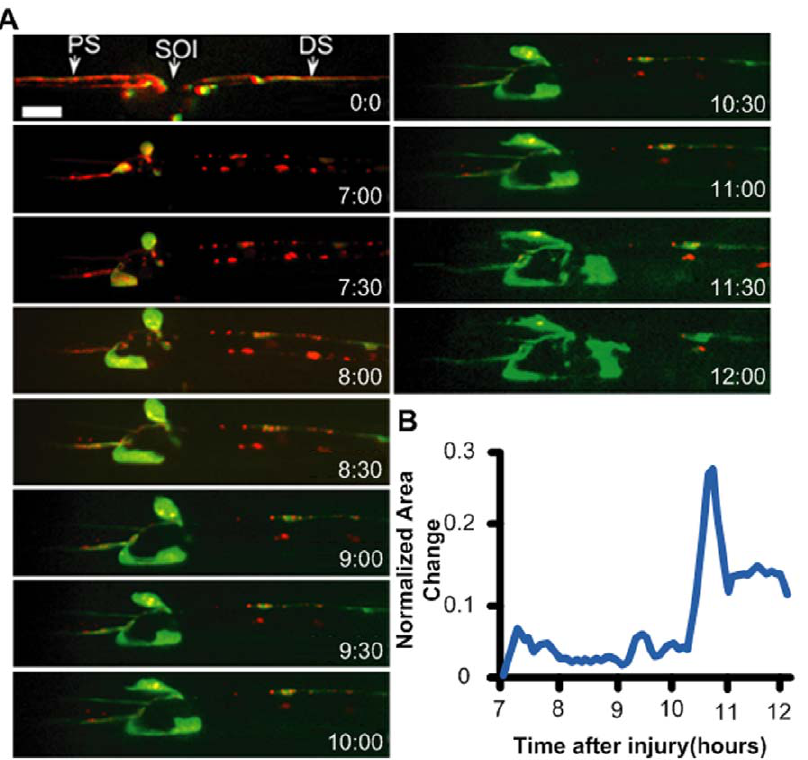
Figure 4. Axonal sprouting after laser injury. (A) In vivo time-lapse images of the proximal stump from 7 hours to 12 hours after laser axotomy. A single enteric motoneuron was visualized by combining the RN2-Gal4_ENREF_48 [48] driver line with UAS-mCD8-RFP (red) to label axonal membrane, and UAS-GFP-moesin [54] (green) to label F-actin. The proximal site (PS) of injury, the site of injury (SOI), and the distal site (DS) of injury are highlighted right after injury (0:00 frame). Scale bar, 10 m m. (b) Normalized area change of the proximal stump over time. Significant movement in the proximal stump is observed , 10.5 hours after injury.